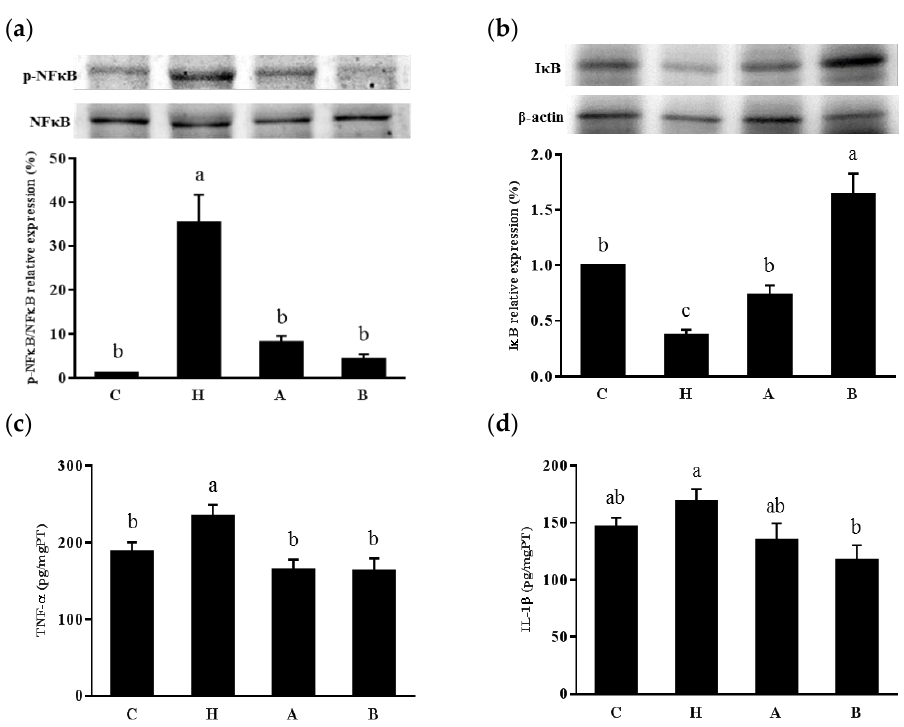
Figure 5. Kidney ( a ) phospho-nuclear factor (NF)- κ B and NF- κ B expressions; ( b ) inhibitor of NF- κ B expressions (I κ B), and proinflammatory cytokine; ( c ) tumor necrosis factor (TNF)- α ; and ( d ) interleukin (IL)-1 β levels in rats. Values are presented as the mean ± SEM ( n = 10). a b c Values with different superscript letters at the end of the study significantly differ ( p < 0.05). C, control group; H, hypertensive group; A, 20 mg/kg/day antroquinonol group; and B, 40 mg/kg/day antroquinonol group.